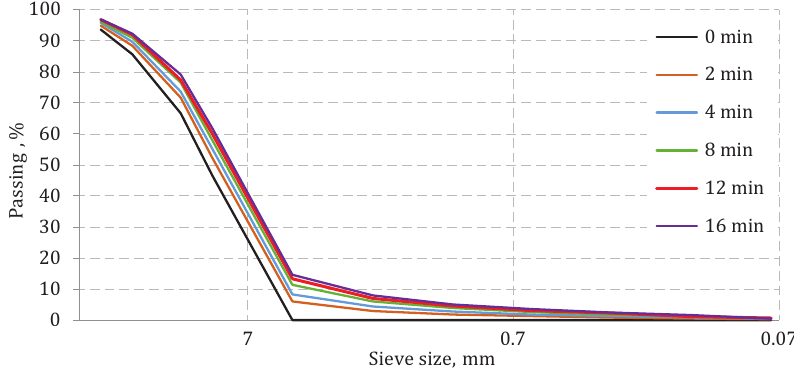
Figure 5. Gradation of RAP aggregates after each step of